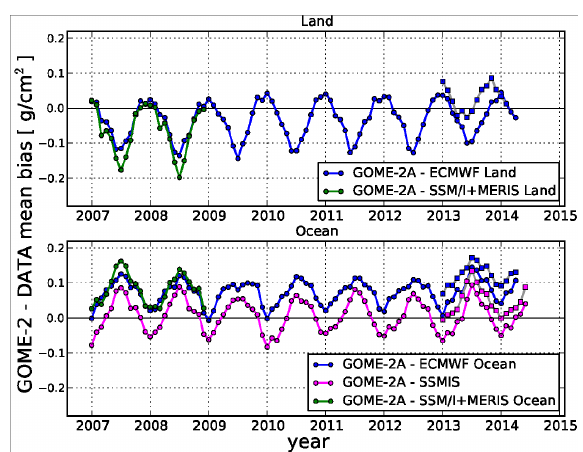
Figure 9. Global monthly mean bias between GOME-2/MetOp- A and three independent TCWV data sets for the period January 2007–June 2014, depending on availability of the data. The bias is computed separately for land (top panel) and for ocean surfaces (bottom panel). Coloured squares and grey lines show the bias for the GOME-2/MetOp-B data